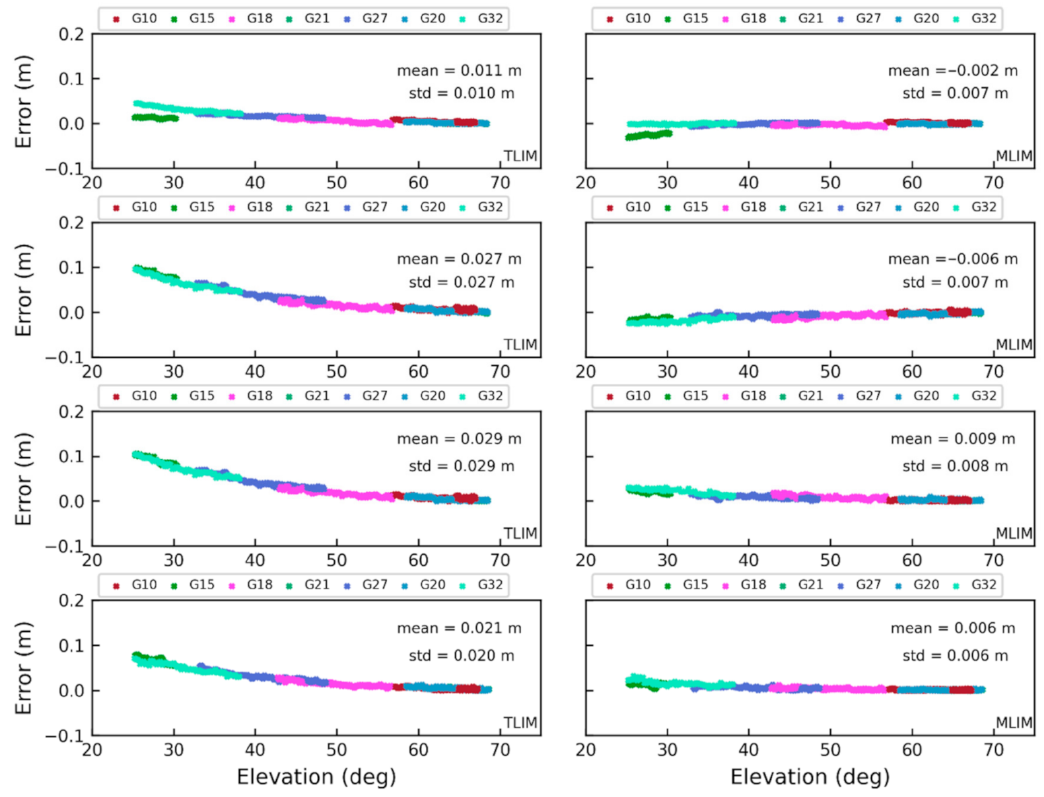
Figure 15. DD tropospheric delay interpolation errors obtained by the TLIM and MLIM (left and right) with different satellite elevation angles at different rover stations (from top to bottom): P532, P539, P602, and